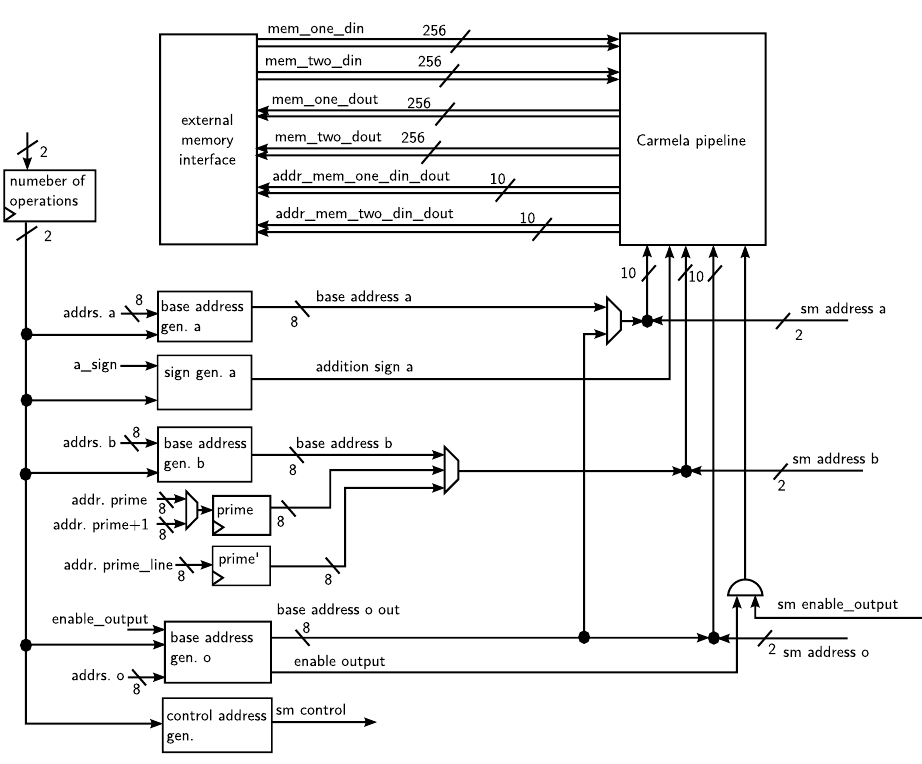
Figure 10: Carmela256 with address resolution and memory